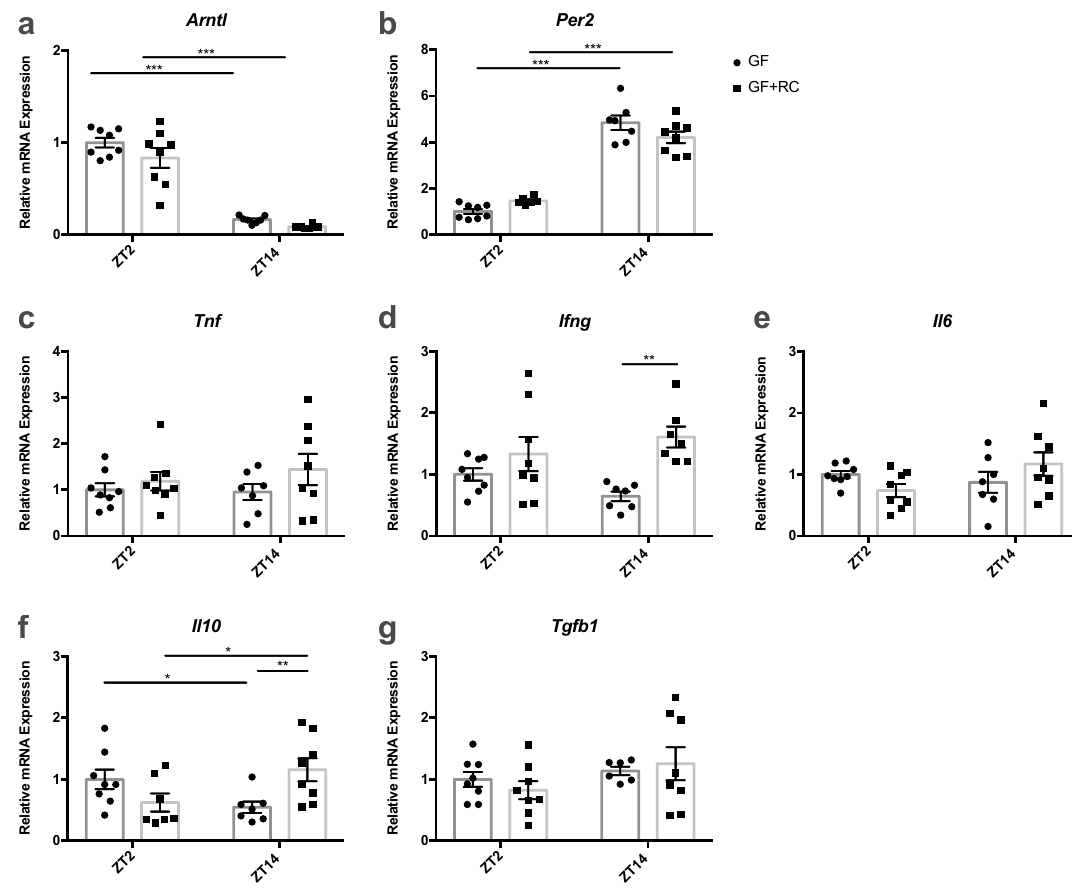
Figure 4. Intestinal mucosal gene expression is partially restored following FMT. ( a ) Arntl , ( b ) Per2 , ( c ) Tnf , ( d ) Ifng , ( e ) Il6 , ( f ) Il10 , and ( g ) Tgfb mRNA expression measured from SI mucosa isolated at ZT2 and ZT14 from GF and GF-mice following FMT with RC-microbiome (GF + RC) measured at ZT2 and ZT14. n = 3–4 male and 3–4 female mice. * p < 0.05 ** p < 0.01 *** p <